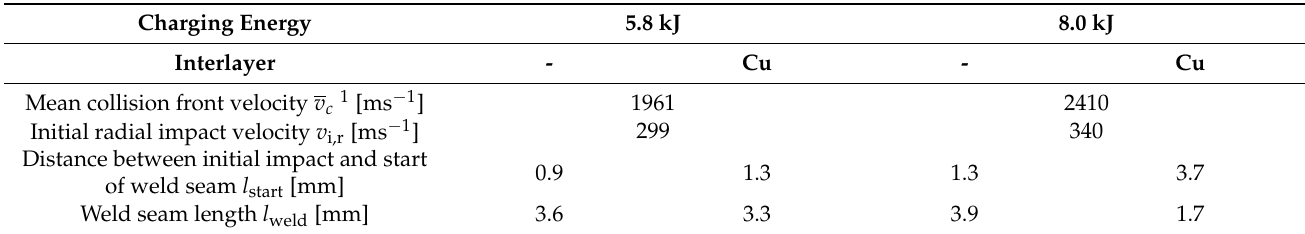
Table 5. Mean collision front velocities v c , initial radial impact velocities v i,r based on a steady acceleration adapted from [18], weld seam start and length for two energy levels with and without interlayers [18] at the 180 ◦